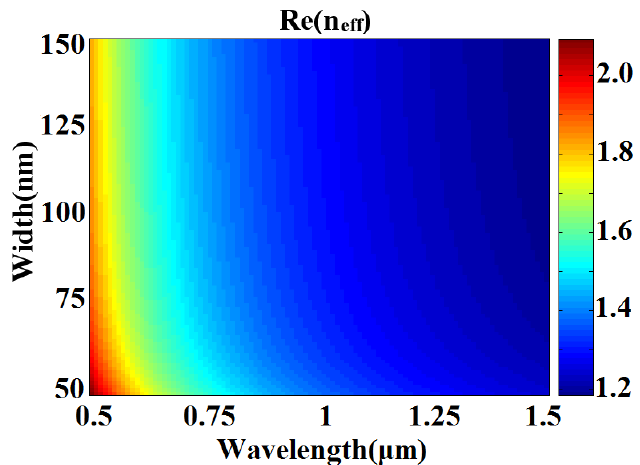
Figure 2. Real part of the effective refractive index n eff vs. the incident wavelength λ and the slit width ω in MIM waveguide.